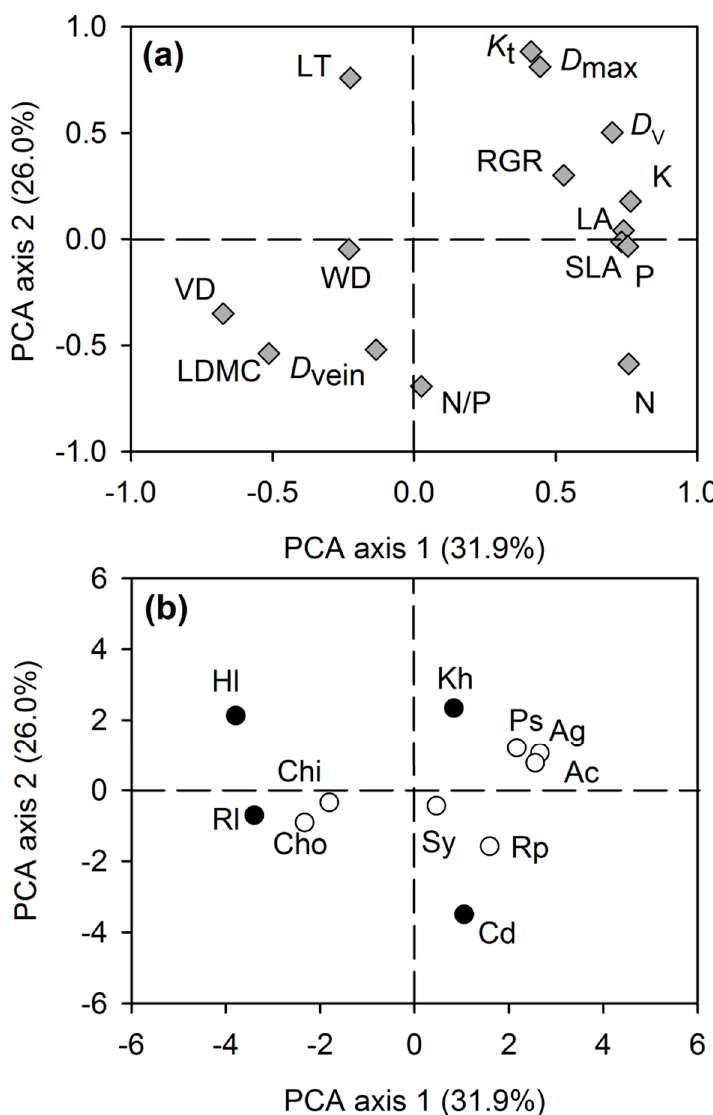
Figure 6. The biplot of the first two axes of the principal component analysis (PCA) for ( a ) the relationships of relative growth rate, leaf, and stem traits and ( b ) the loadings of the seven deciduous (open circle) and four evergreen (filled circle) lianas. See Table 2 for species codes and text for trait abbreviations.